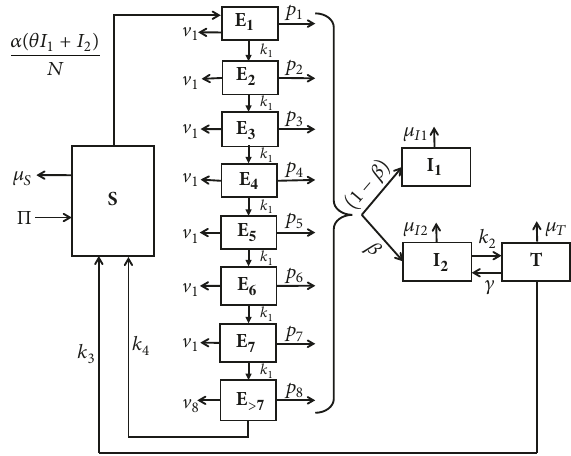
Figure 1: The model:a compartment model for tuberculosis transmis- sion in Nigeria. The model shows the dynamic flow of tuberculosis (TB) including susceptible population 𝑆 ; the latently infected pop- ulation are discerned based on the time since they were infected; therefore 𝐸 1 stands for people latently infected for a period of one year, 𝐸 2 stands for people infected for 2 years, etc.; 𝐸 >7 stands for people that have been infected for more than 7 years; two types of the nondiagnosed sick population are considered, 𝐼 1 and 𝐼 2 , and the sick under treatment is shown as 𝑇 . Birth occurs at constant rate Π . Transmission of Mtb depends on 𝛼(𝜃𝐼 + 𝐼 )/𝑁 and probability 1 2 leading to active TB is given as 𝑝 𝑖 = 𝑎𝑖 2 +𝑏𝑖+𝑐 , where 𝑖 is the 𝑖 𝑡ℎ year of infection. 𝑘 1 indicate succession from one infected compartment to the next. A fraction of the sick, 𝛽 , will be detected and notified; 𝑘 𝛾 2 is related to diagnosis time delay before starting treatment and indicatesa fraction of relapsefor the sick under treatment.Recovery rate is given as 𝑘 3 while 𝑘 4 represents the fraction of the infected population that gets rid of the disease spontaneously. We account for all courses of death, 𝜇 𝑠 , ] 𝑖 , 𝜇 𝐼 , and 𝜇 𝑇 , and death due to active 2 TB, 𝜇 𝐼 1